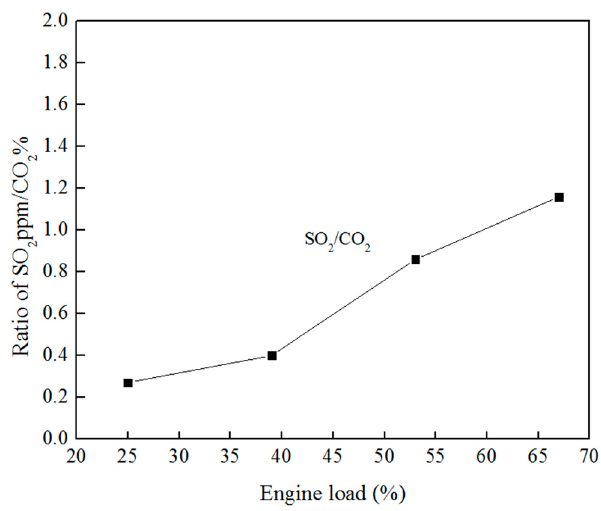
Figure 7. SO 2 (ppm)/CO 2 (%v/v) with different engine loads.